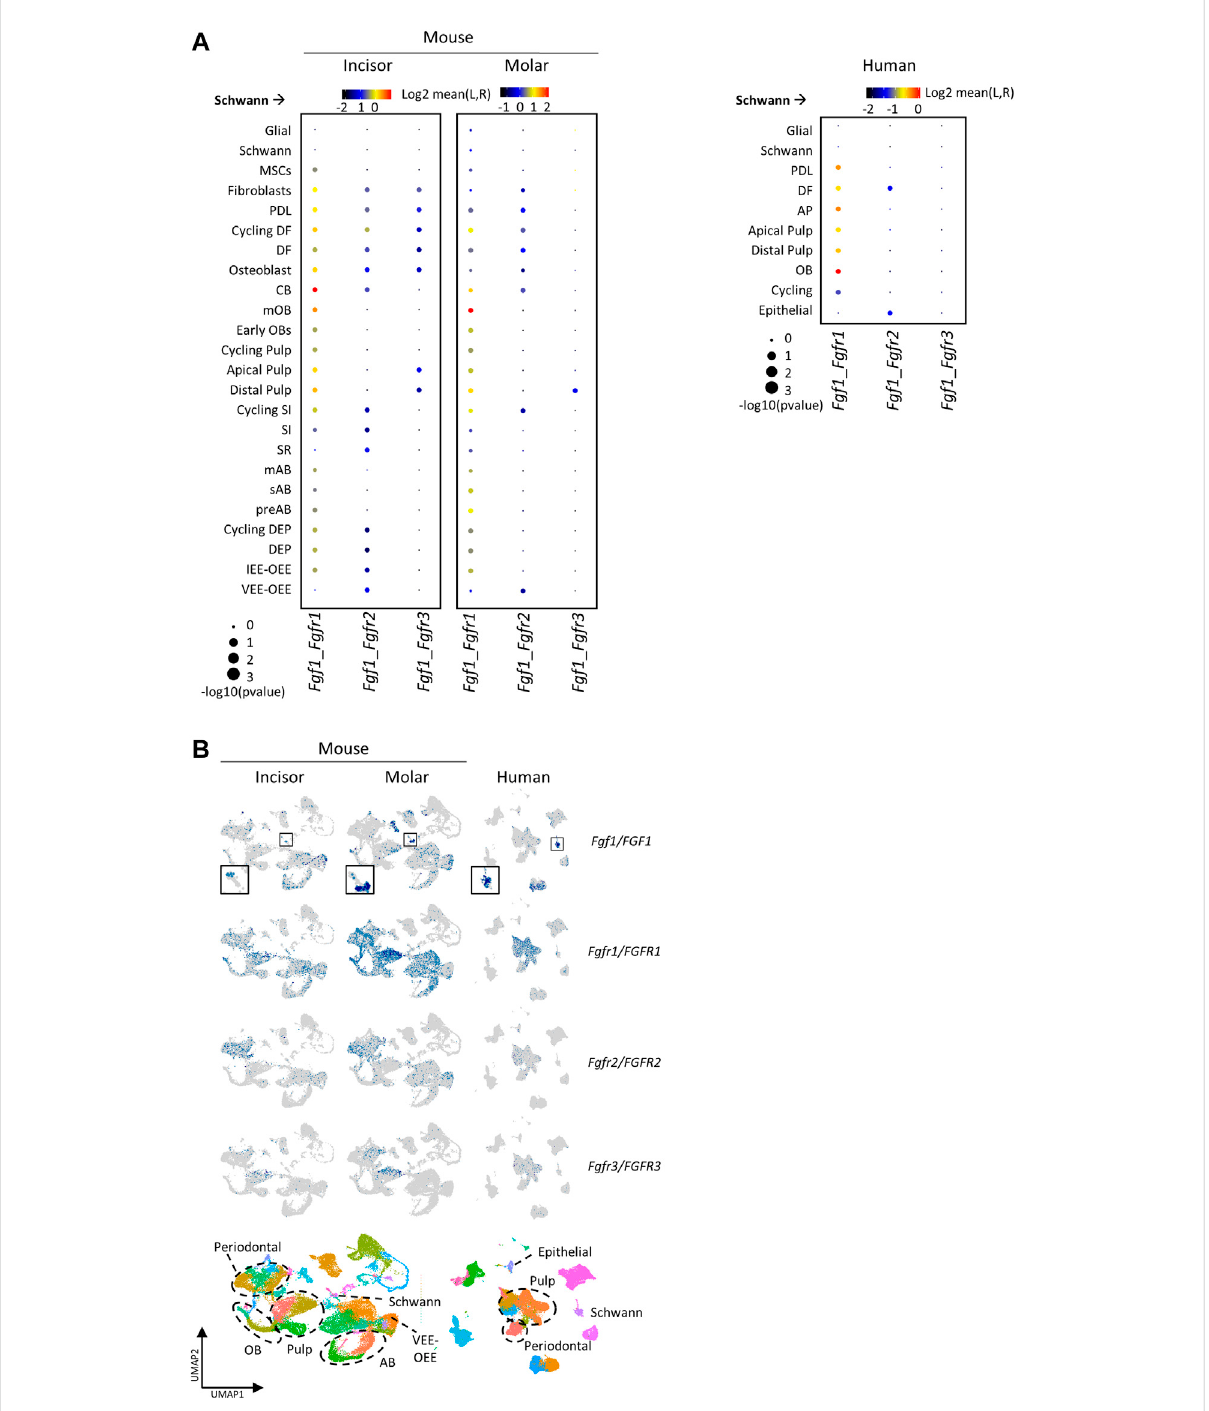
FIGURE 5 Cell-cellsignalinganalysisprojectingFGF1asmessengerfromSchwanntoothercelltypesinhumanandmousetooth. (A,B) Dotplotofselected ligand-receptor interactions originating from the Schwann cell cluster, identi fi ed by CellPhoneDB analysis, in mouse (left) and human (right). Size of dotsindicatesthe p valueoftheprojectedinteraction,andcolorintensitythemeansoftheaverageexpression levelsofligand(L)intheSchwanncell cluster and receptor (R) in the other clusters. (B) Gene expression plots of identi fi ed ligands/receptors in mouse and human (top), and mouse and human tooth atlases with relevant clusters highlighted